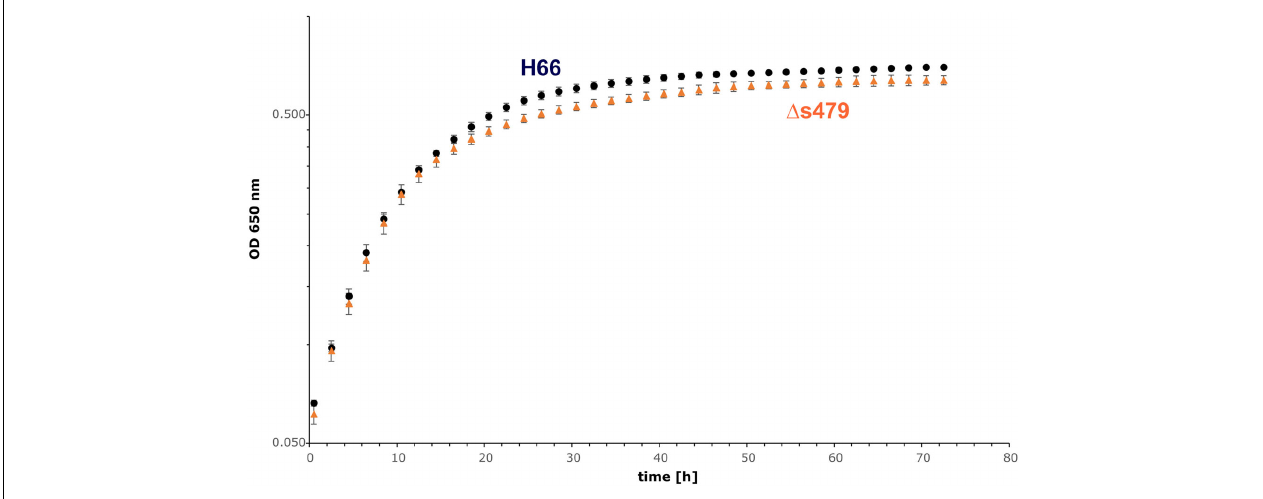
FIGURE 5 | Growth experiment comparing the wild-type strain and (cid:49) s479 strain. Both strains were cultivated in triplicate with Hv-Ca medium (supplemented with uracil) in microtiter plates and OD 650 nm was monitored using a heated plate-reader instrument.